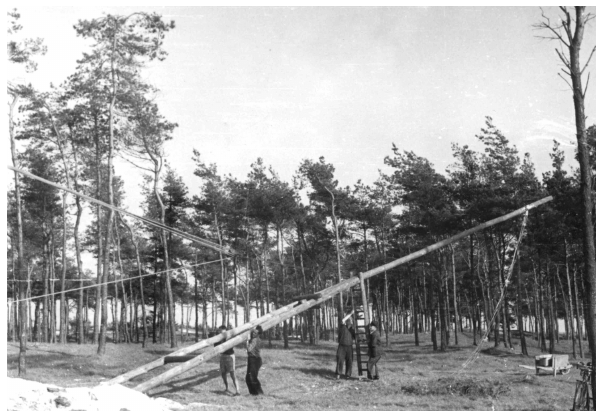
Figure 9. Erection of the first antenna masts in 1954.